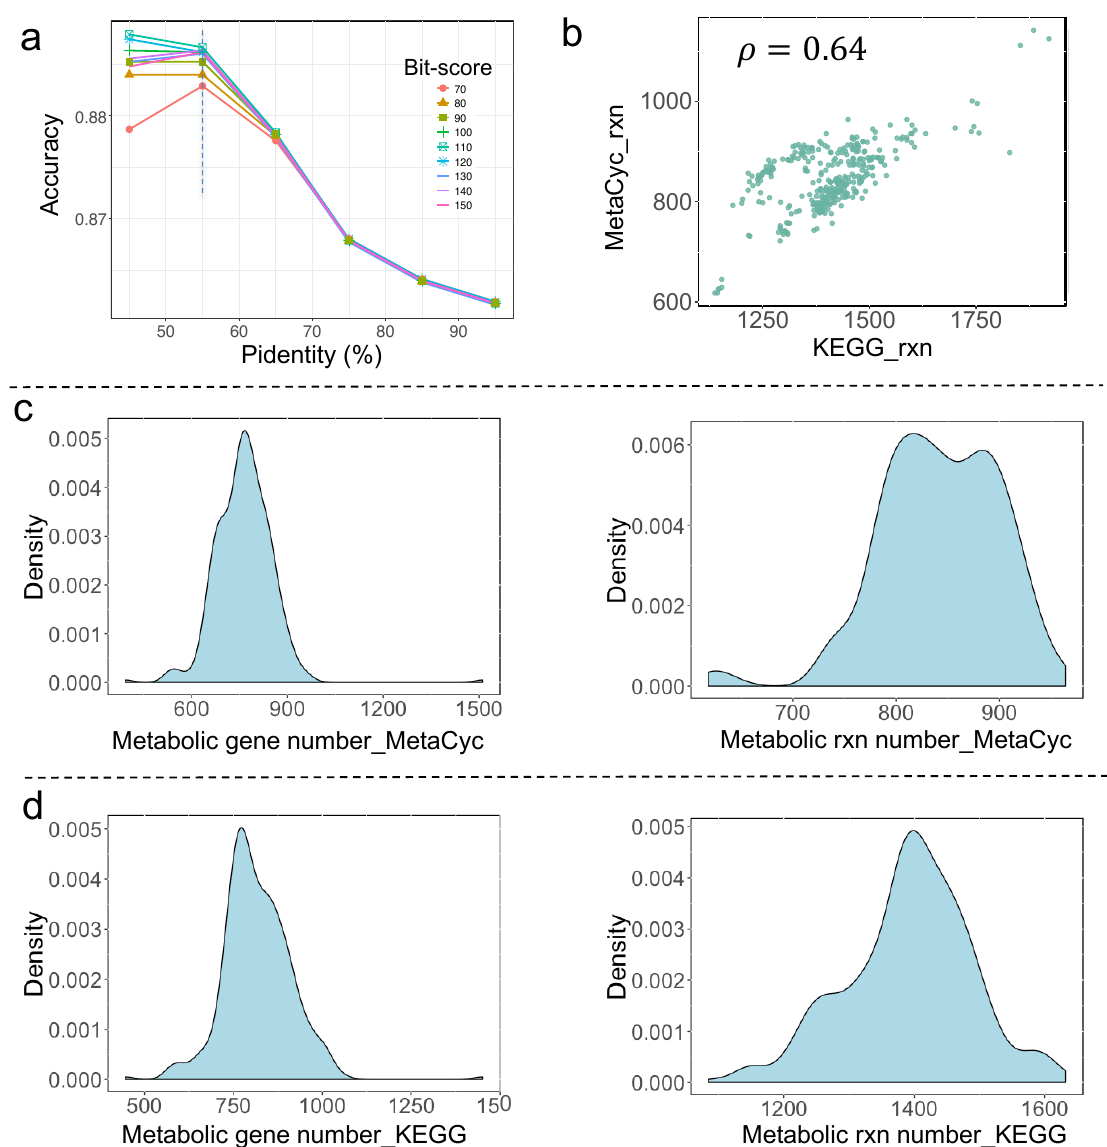
Figure 1. Draft yeast species-specific metabolic model reconstruction using the RAVEN toolbox: ( a ) Effects of the parameters’ cut-offs on model quality (defined as accuracy) from the RAVEN